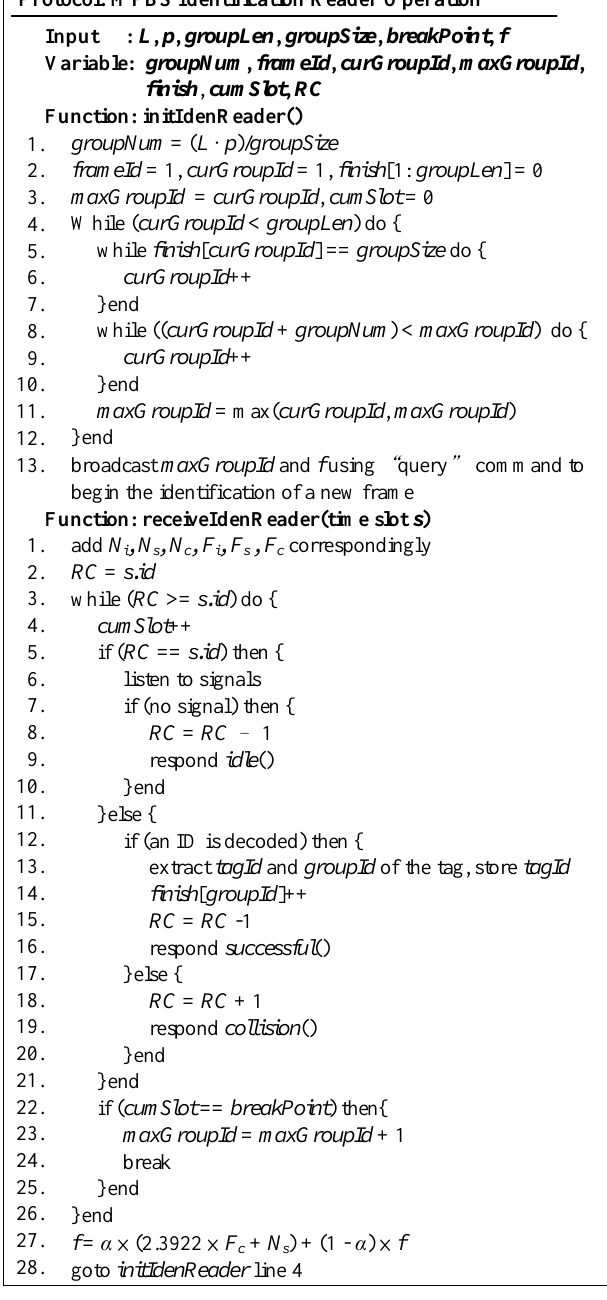
Figure 9. Code for identification reader.